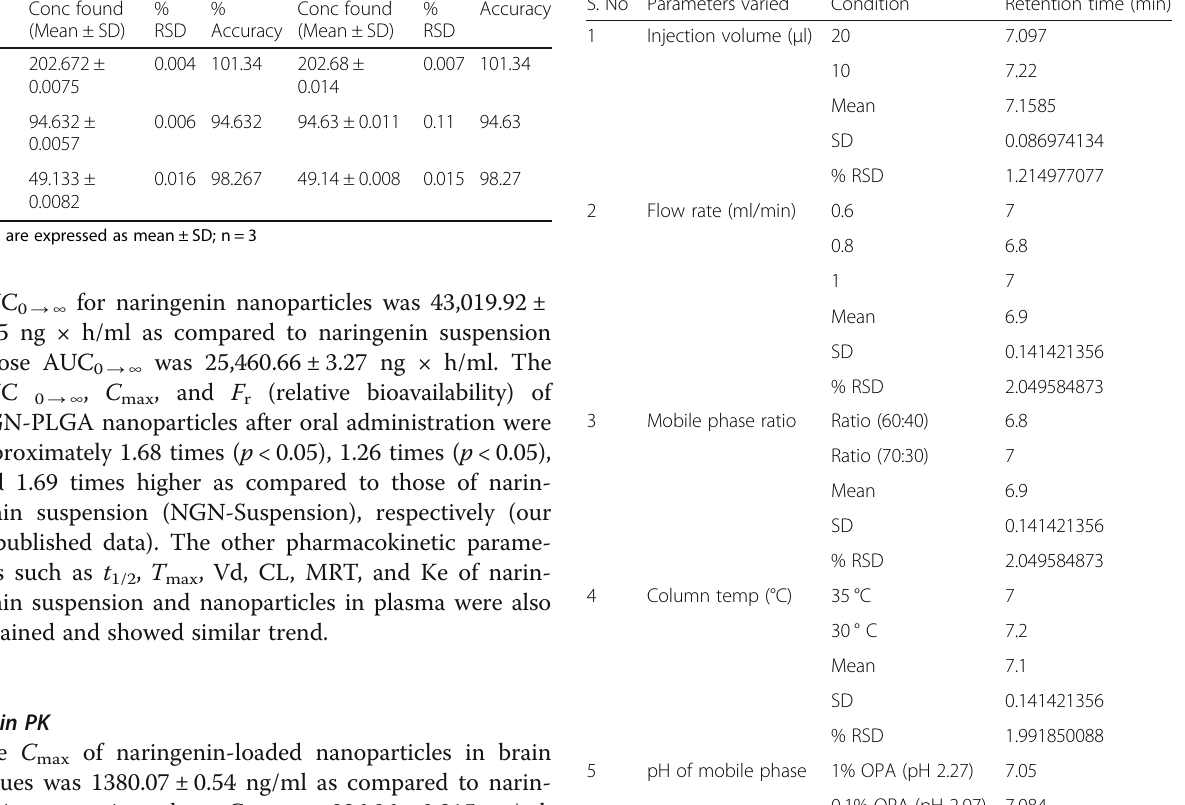
Table 5 Precision of the assay for naringenin in rat plasma Conc (ng/